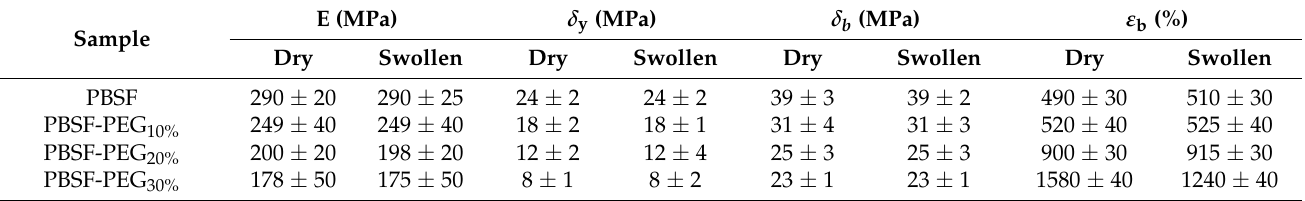
Table 4. Mechanical characterization date of the dry and swollen PBSF and PBSF-PEG